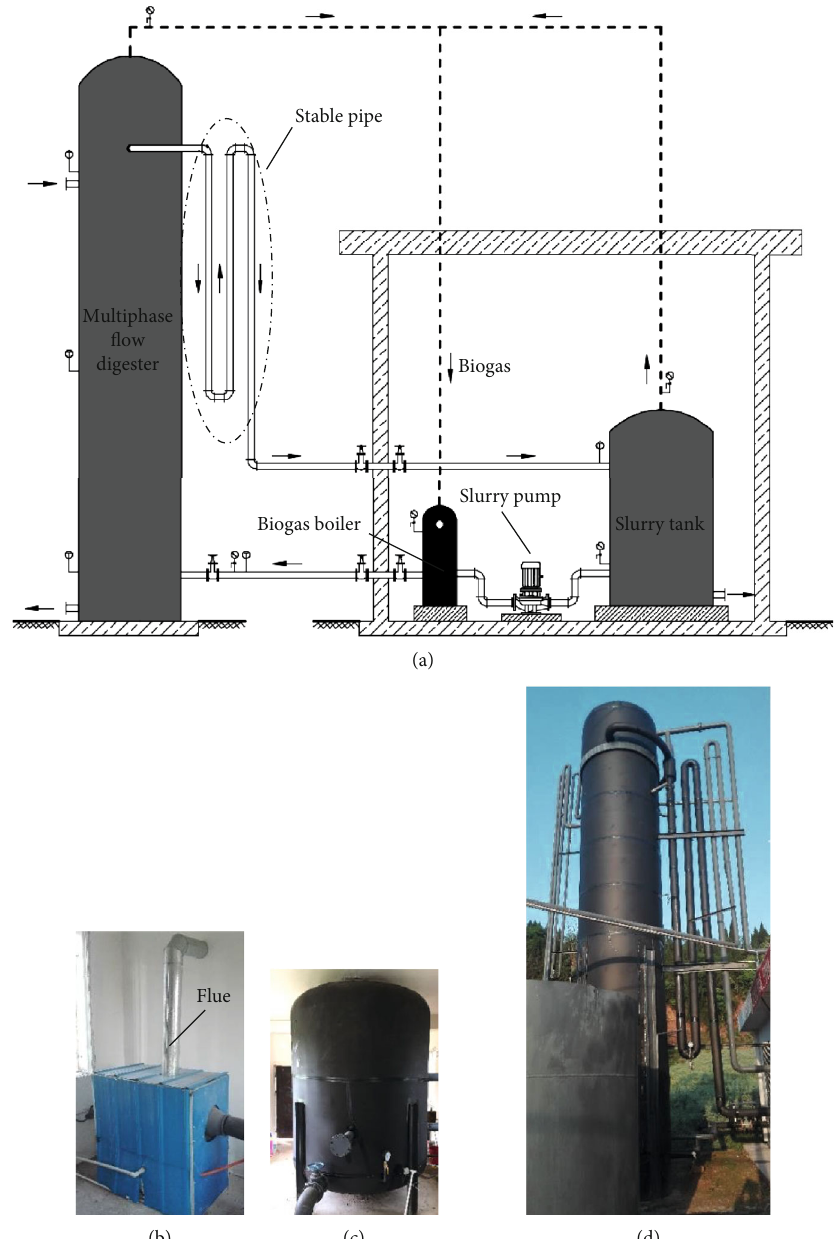
Figure 1: The anaerobic digestion system: (a) schematic diagram of multiphase fl ow digestion system; (b) image of biogas boiler; (c) image of slurry tank; (d) image of multiphase fl ow